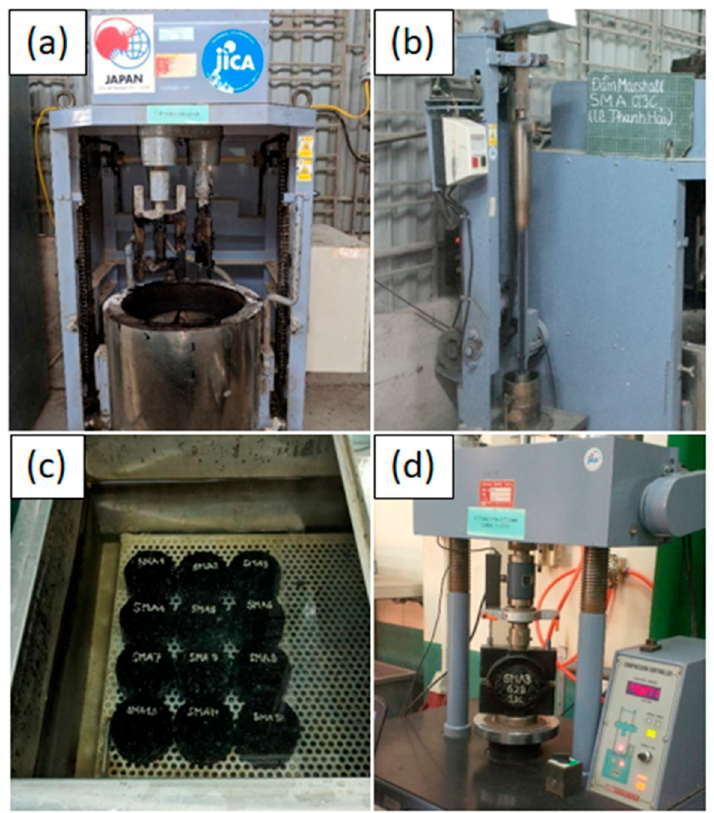
Figure 2. The SMA samples preparation and testing: ( a ) Asphalt mixer, ( b ) Marshall Automatic Compaction machine, ( c ) The SMA samples in hot water bath, and ( d ) Automatic Stability Testing machine.